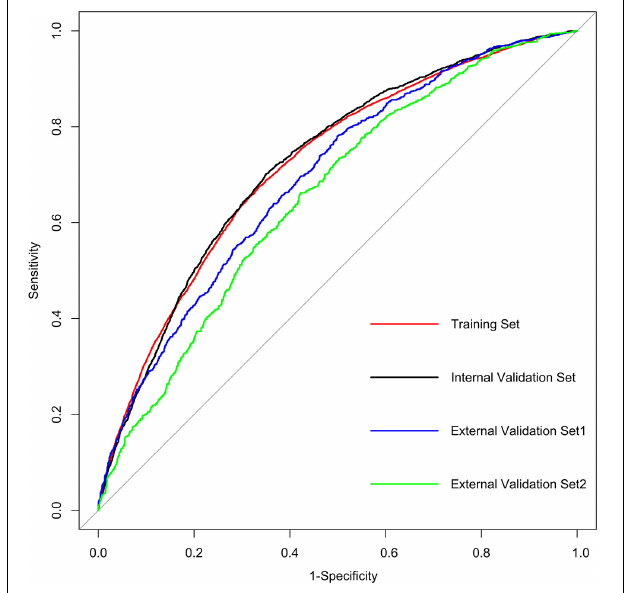
FIGURE 3 | AUC of the ROC curve in training set, internal validation set, external validation set1 and external validation set2.